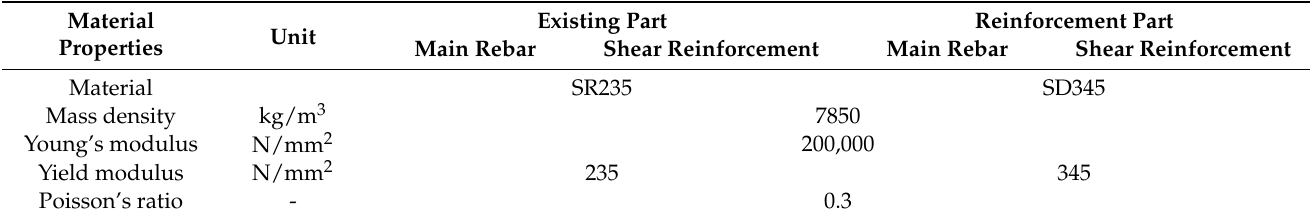
Figure 15. Concrete stress − crack displacement relationship (tension side). Table 4. Physical characteristics of steel materials.